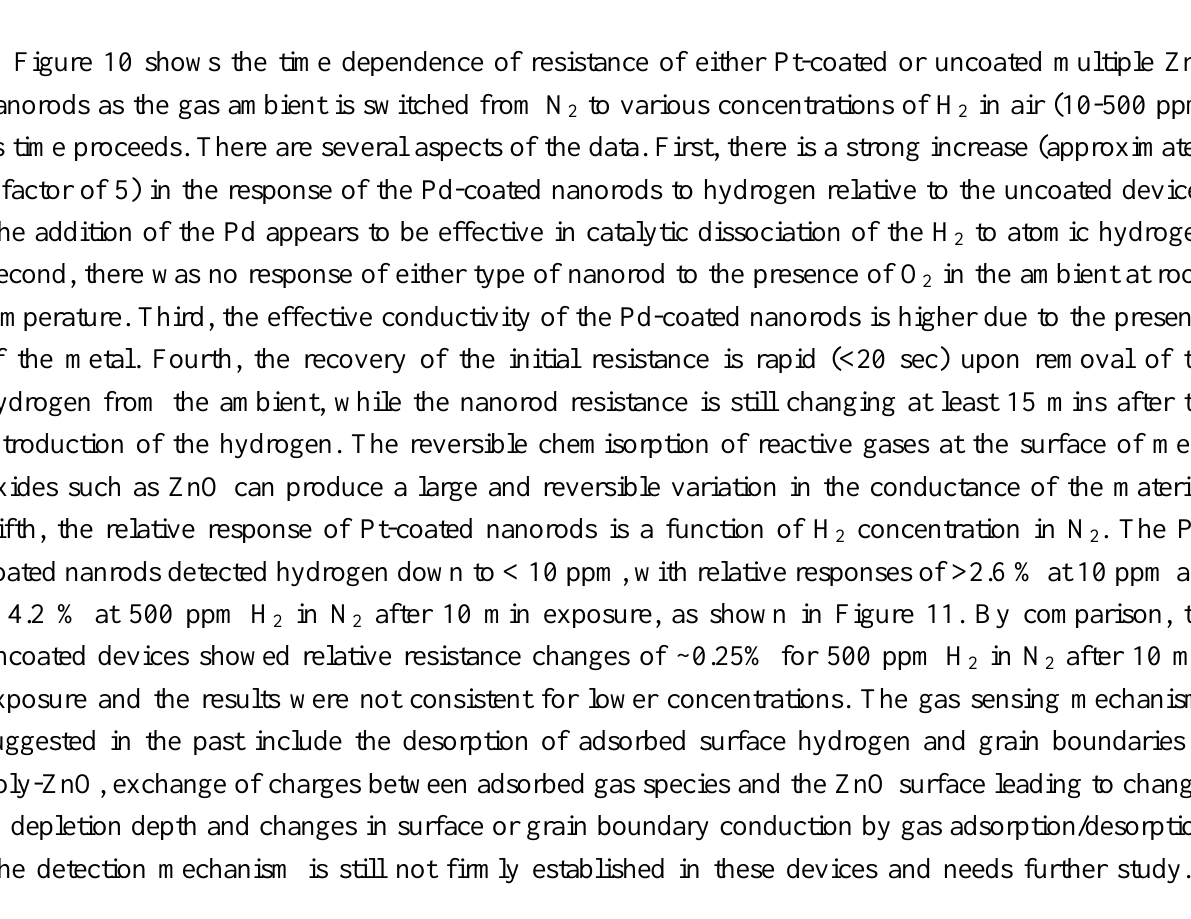
to various concentrations of H 2 2